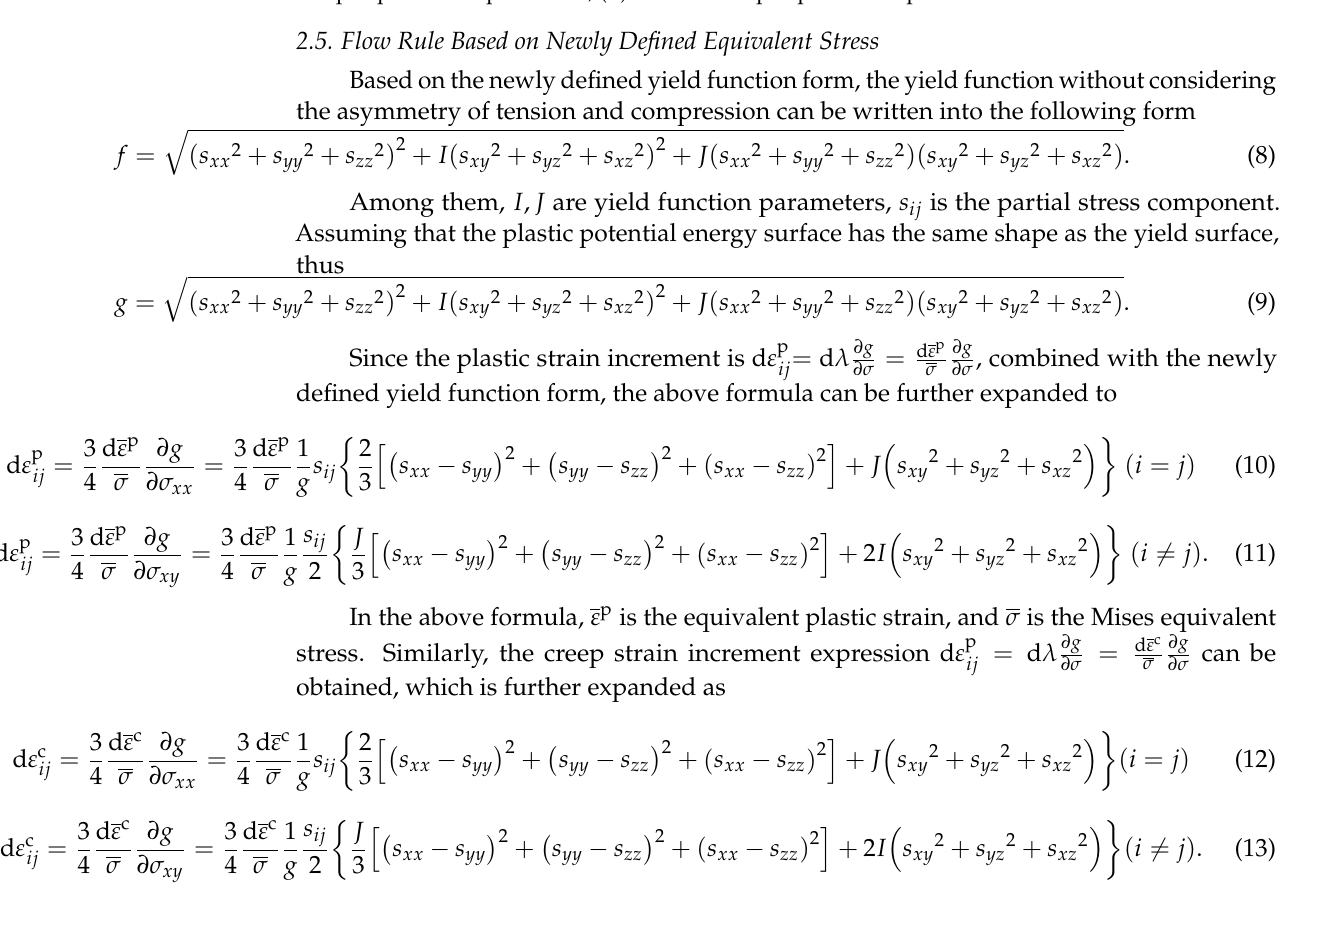
Figure 7. Prediction results of creep rupture time in different crystal orientations at different temper- atures. ( a ) 760 ◦ C creep rupture time prediction, ( b ) 850 ◦ C creep rupture time prediction, ( c ) 980 ◦ C creep rupture time prediction, ( d ) 1070 ◦ C creep rupture time